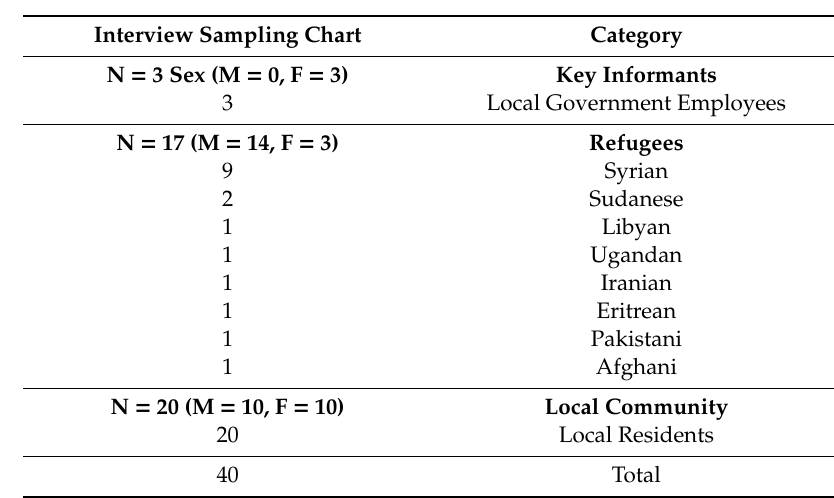
Table 1. Interview Sampling